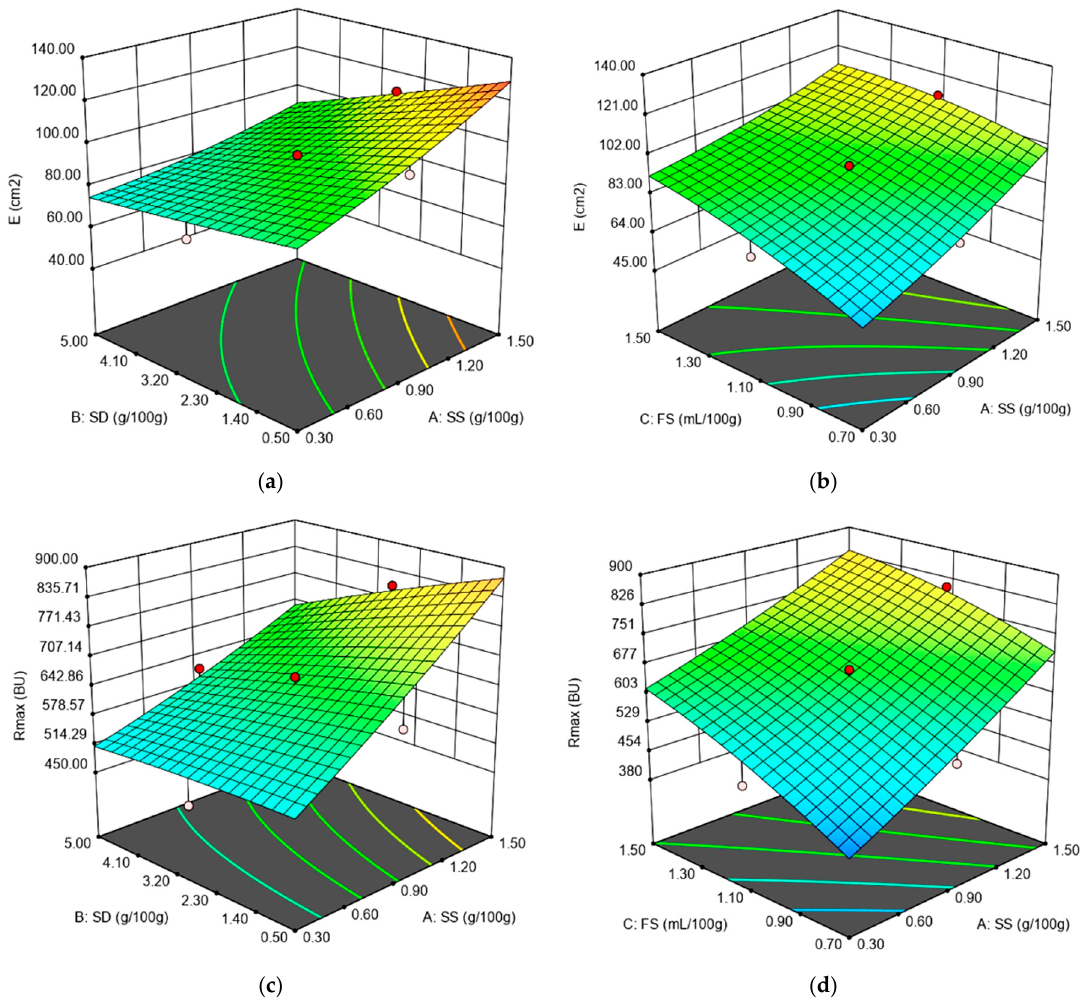
Figure 2. Graphical representations of the Extensograph parameters: ( a ) energy (E) as affected by the levels of sea salt (SS) and dry sourdough (SD) incorporated in wheat flour at 1.10 (mL/100 g) fermented sugar; ( b ) energy (E) as affected by the levels of sea salt (SS) and fermented sugar (FS) incorporated in wheat flour at 2.75 (g/100 g) dry sourdough; ( c ) maximum resistance (R max ) as affected by the levels of sea salt (SS) and dry sourdough (SD) incorporated in wheat flour at 1.10 (mL/100 g) fermented sugar; ( d ) maximum resistance (R max ) as affected by the levels of sea salt (SS) and fermented sugar (FS) incorporated in wheat flour at 2.75 (g/100 g) dry sourdough.